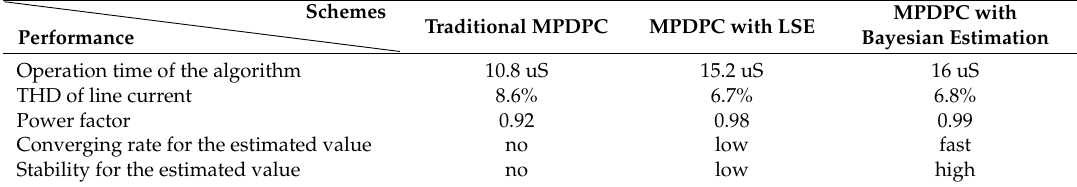
Table 2. Performance Comparison of Three MPC methods under the inductance variation.